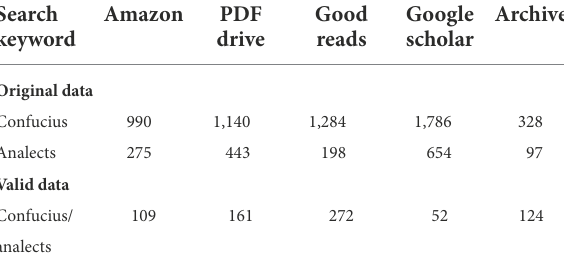
TABLE 1 Number of hits from the original data and the valid